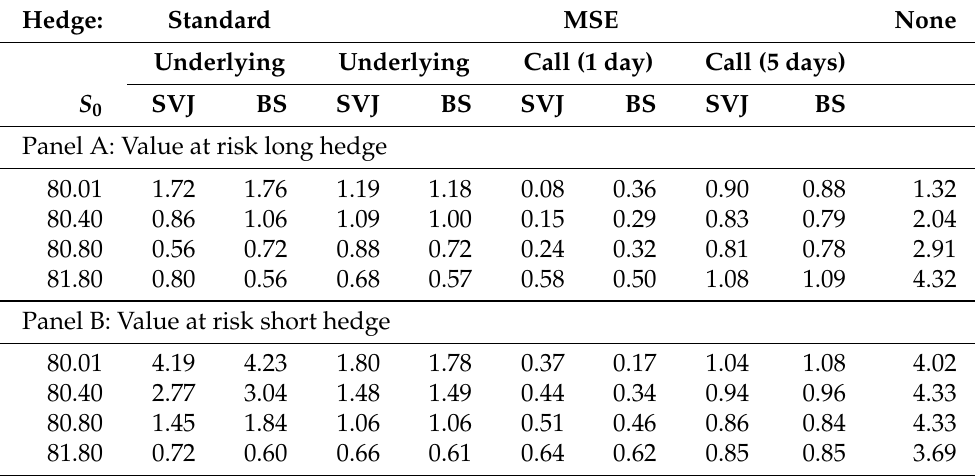
Table 2. SVJ model with overnight trading gap: 95% value at risk. Hedging object is a down-and- out put with K = 100, B = 80, and T = 20 days; the hedging period is ∆ t = 1 day. The different strategies are model delta, MSE delta using the underlying and MSE delta using vanilla calls with time to maturity of 1 or 5 days, and no hedging. For each strategy, hedges are calculated with the correctly specified model (SVJ) and as an approximation with the semi-analytical formulas in the Black–Scholes model